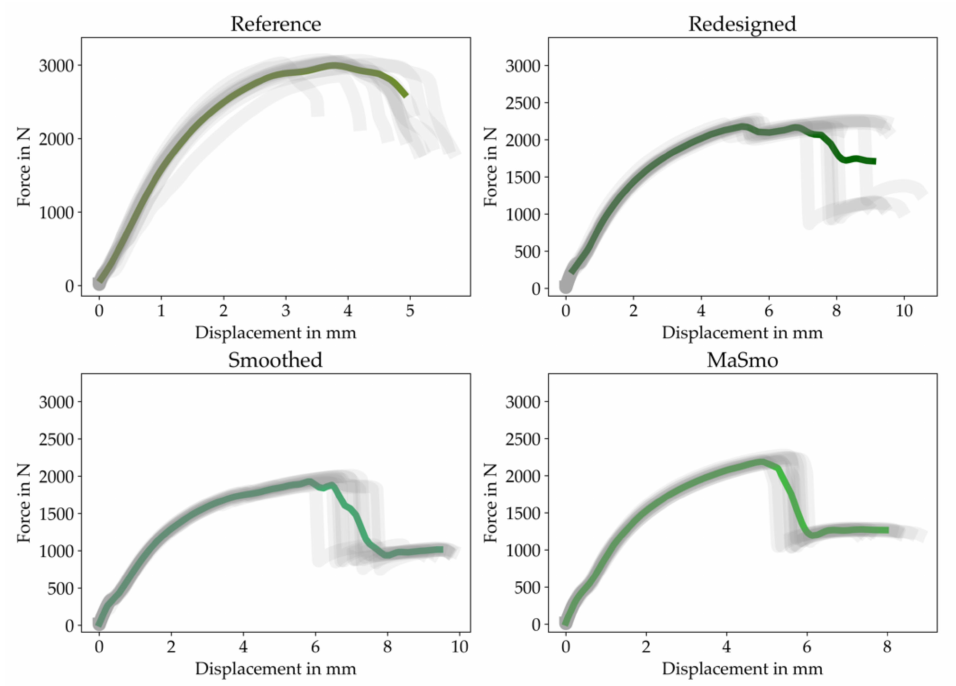
Figure 16. Force–displacement plots for all configurations. The grey shaded lines are the experimental data, the green lines are predicted with the trained Gaussian process regression (gpr) model. From the presented data, it is evident that the MaSmo configuration was the least noisy, leading to a good reproducibility of the “one-click” optimized part. The approximated curves of all configurations are compared in Figure 17.